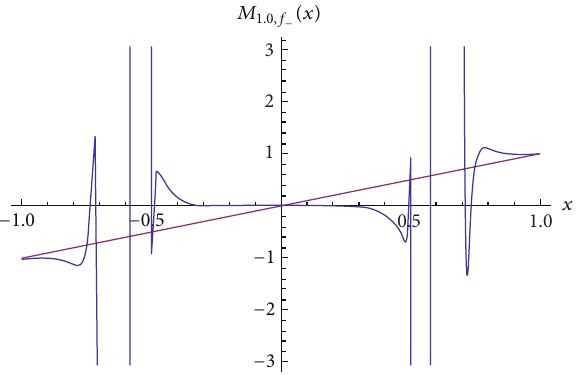
Figure 21: 𝑀 𝑓 steps.